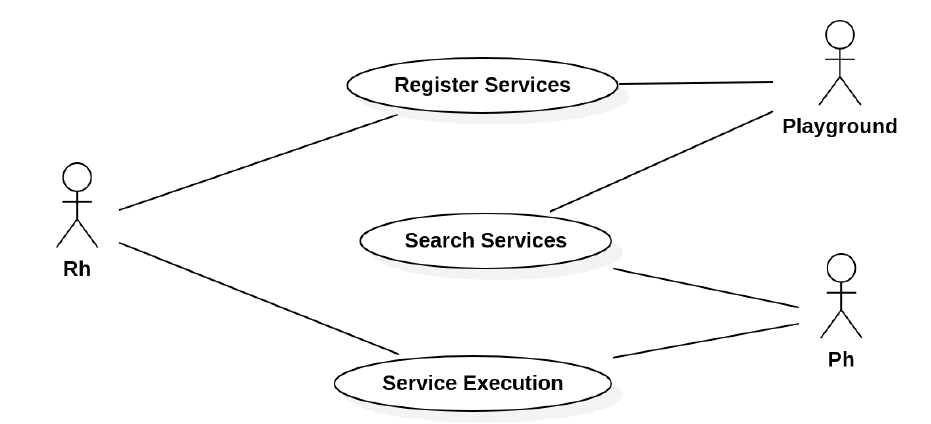
Figure 5. Interaction between Ph, Rh, and Playground.